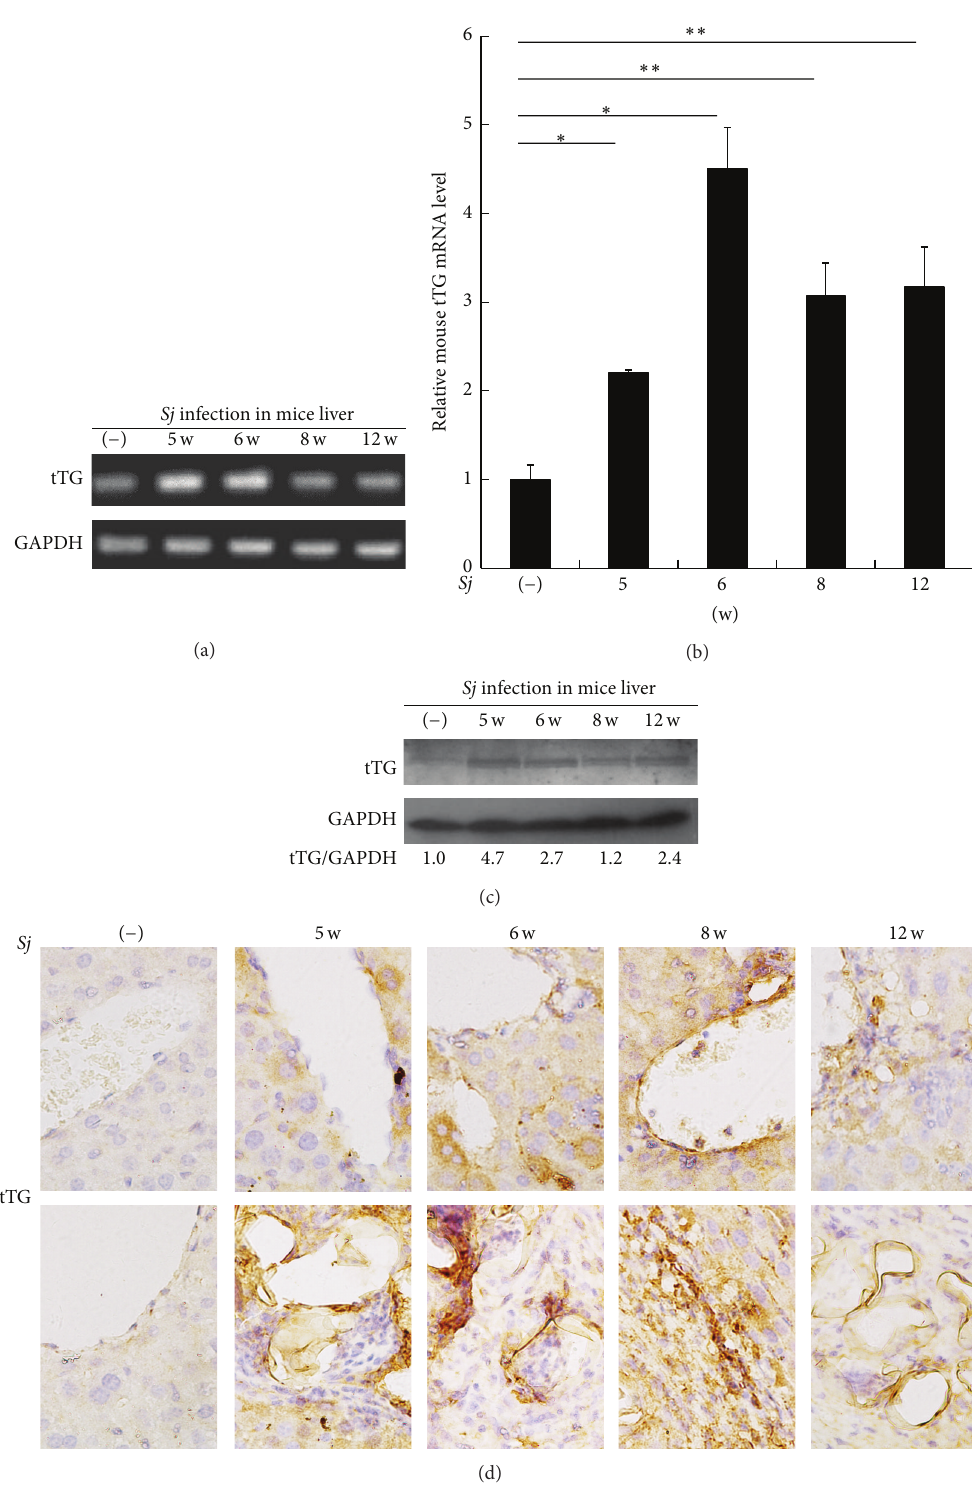
Figure 3: tTG expression was upregulated progressively in mice liver after Sj infection. (a, b) tTG mRNA level in BABL/c mice liver is upregulated at weeks 5, 6, 8, and 12 after Sj infection, as determined through RT-PCR and Q-PCR. GAPDH is detected as an internal control. Data are presented as mean ± SD from eight mice per group. ∗ 𝑃 < 0.05 and ∗∗ 𝑃 < 0.01 compared with noninfected mice ( − ). (c) tTG protein level of mice liver homogenates is tested by Western blot analysis. GAPDH is used as loading control. (d) Different localization expression levels of tTG protein in BALB/c mice liver are shown through IHC assay at weeks 5, 6, 8, and 12 after Sj infection. Upper panel: extent of tTG positive staining in hepatic cell and liver tissue around the liver sinusoid. Lower panel: extent of tTG positive staining in the granuloma and nearby liver tissue after Sj egg deposition. Representative tTG staining sections are shown at 40x